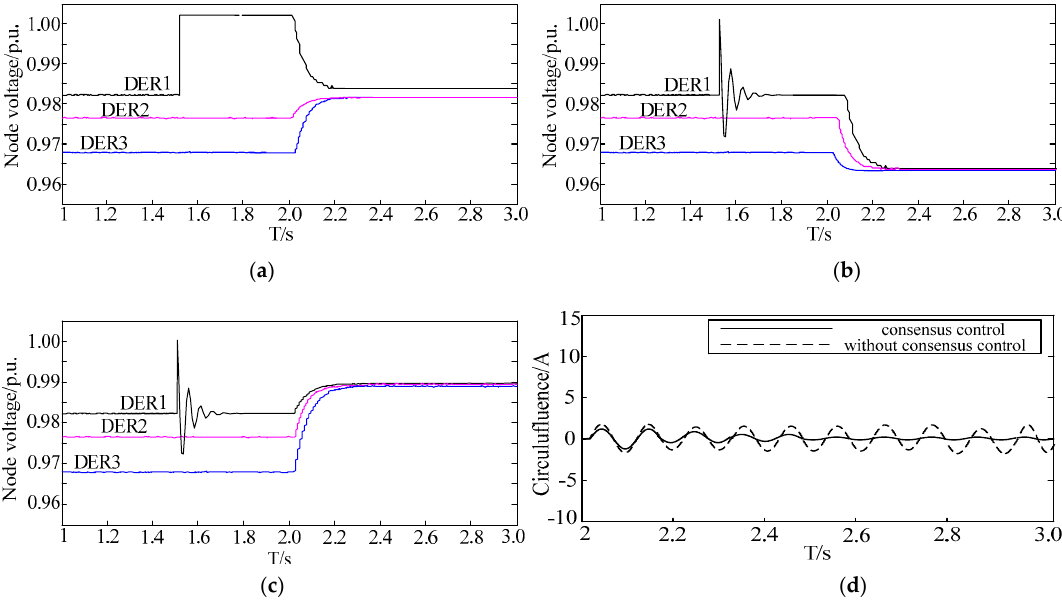
Figure 12. Control effect on designed sliding mode control (SMC) and coordinated controller. ( a ) The variations of node voltages of DERs without using SMC when increasing Load2 at t = 2 s; ( b ) The variations of node voltages of DERs when increasing Load2 at t = 2 s; ( c ) The variations of node voltages of DERs when cutting off Load2 at t = 2 s; ( d ) The circumfluence of the node.